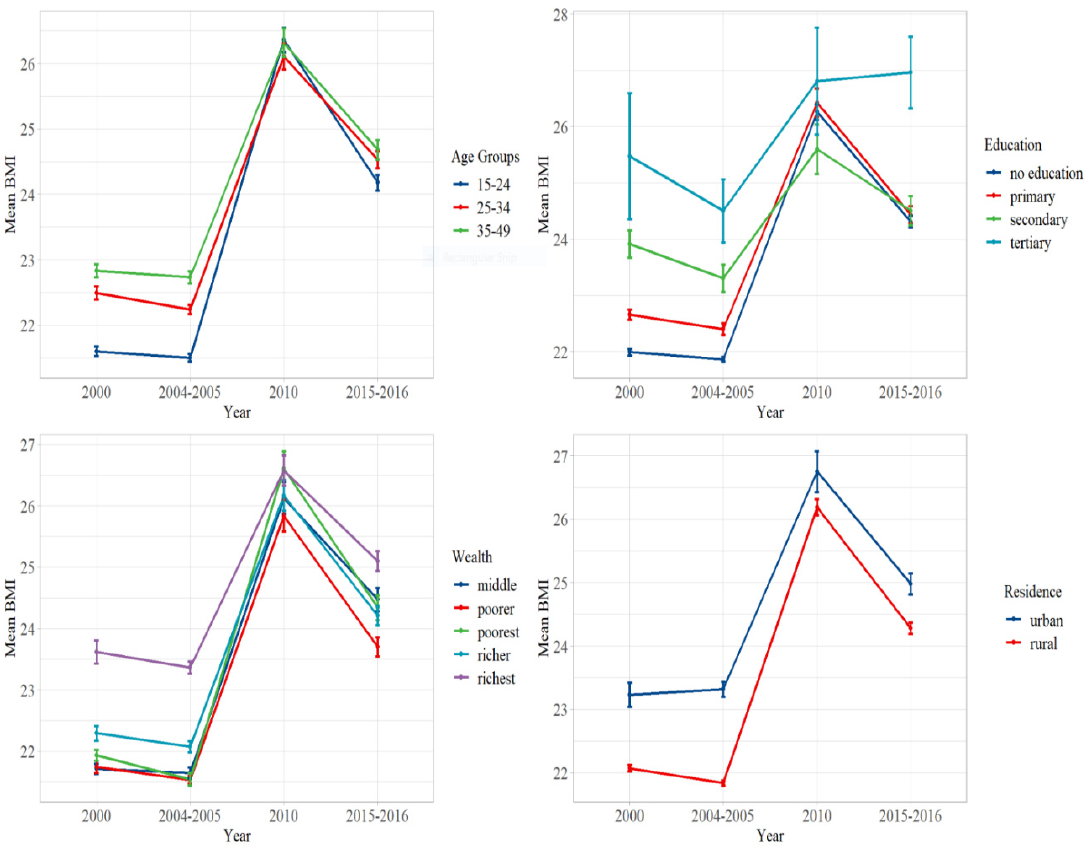
Figure 2. Average body mass index of females in different demographic groups in Malawi.